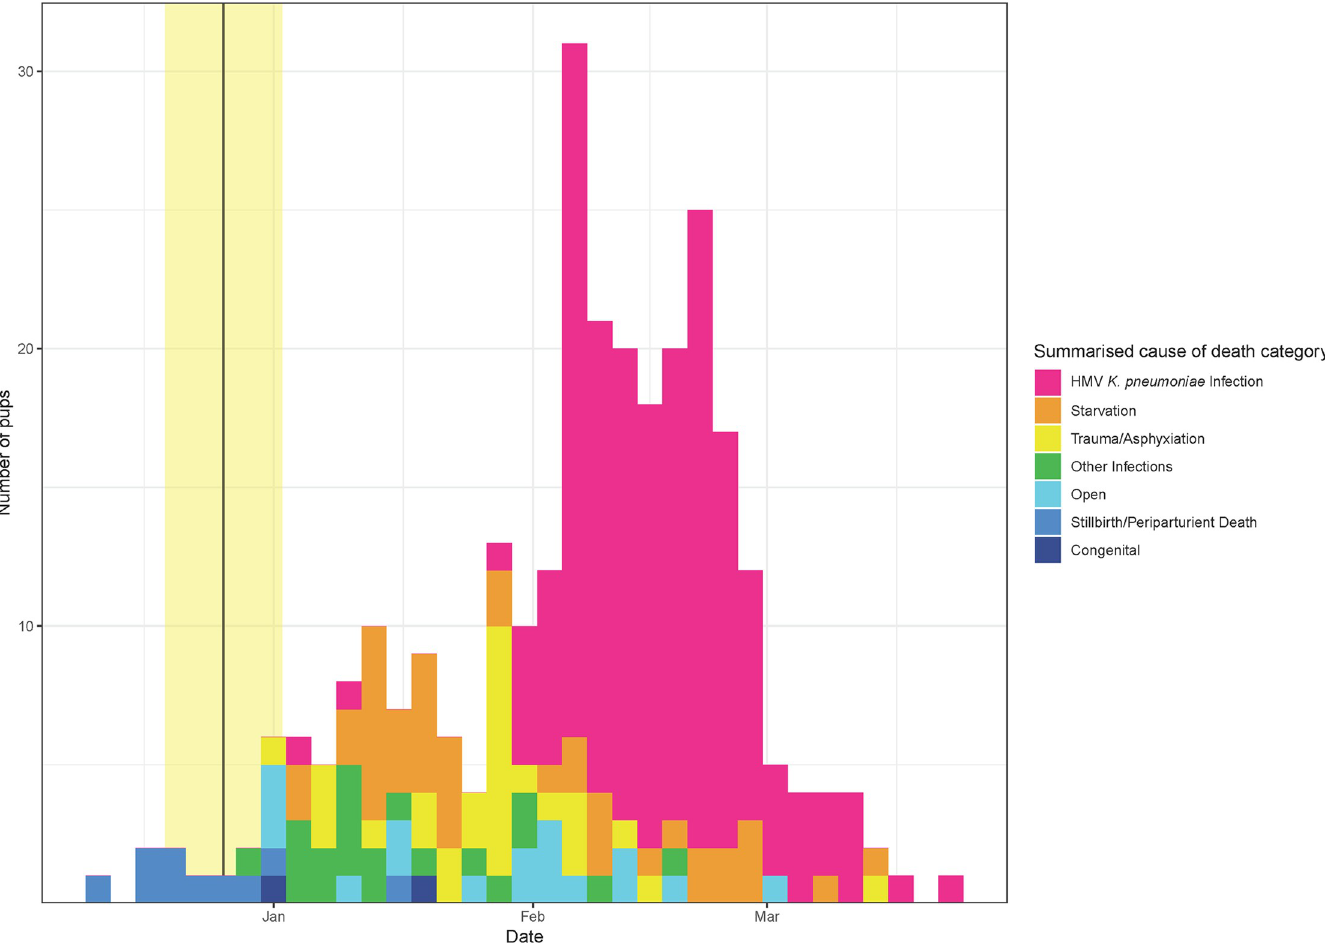
Fig 4. Histogram of summarised cause of death in New Zealand sea lion ( Phocarctos hookeri ) pups at Enderby Island with seasons 2013–14 to 2017–18 combined. The yellow shaded area indicates the approximate timing of 69% of pupping with median pupping date of 26 December [1].